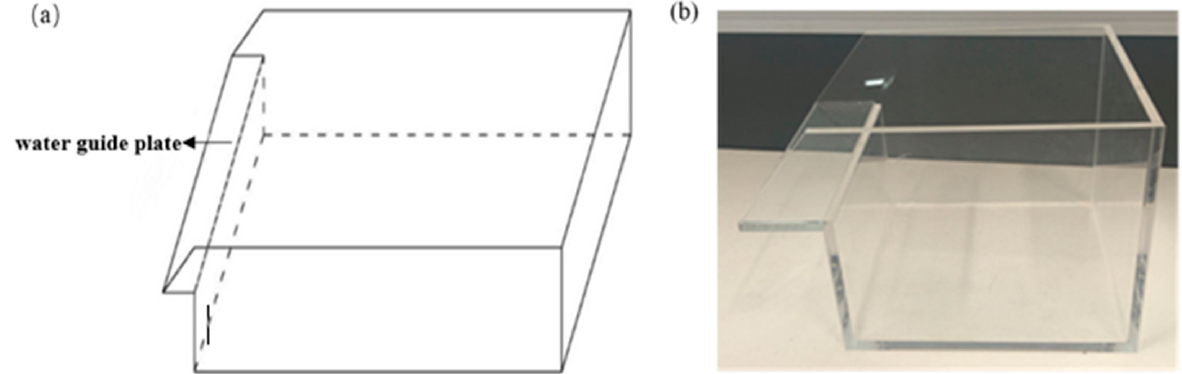
Figure 2. Schematic and physical map of a simple landfill soil cover model.